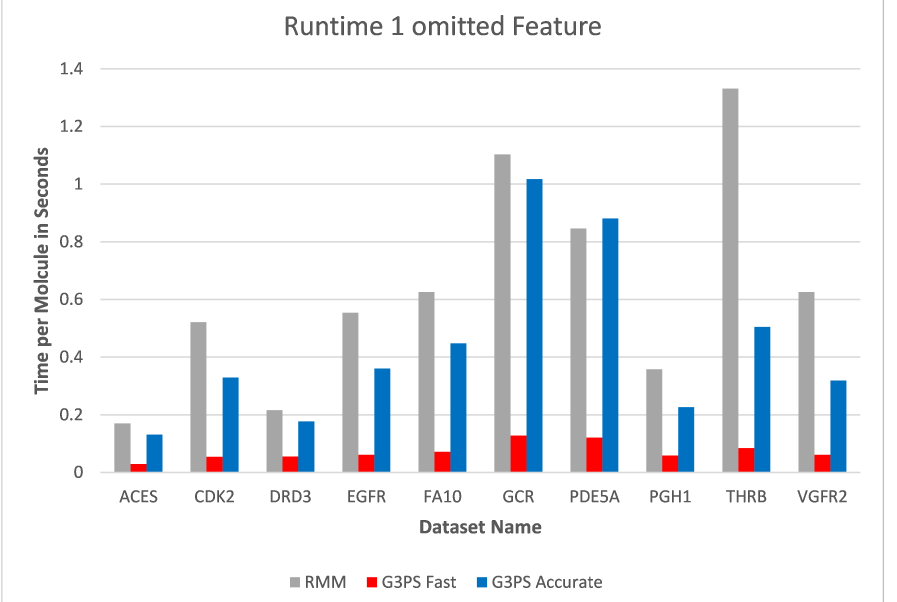
Figure 12. Screening benchmark runtimes with one omitted feature.